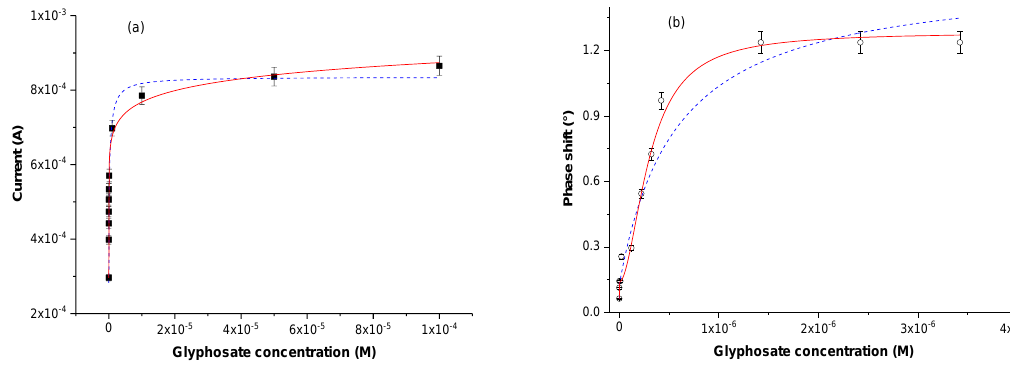
Figure 6. ( a ) Peak current variation versus Gly concentration; comparison between two sites binding model (blue line) and combined model (red line). ( b ) Cumulative absolute values of phase shifts according to Gly concentration (dashed blue line: two sites binding model; solid red line: combined model).